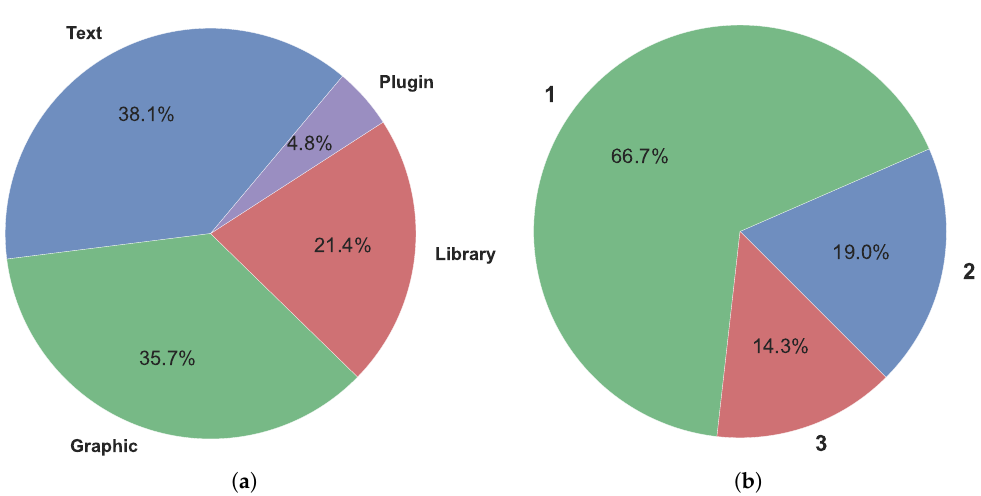
Figure 3. User interfaces implemented in the selected software packages: ( a ) by percentage; and ( b ) by number of interfaces used in a single package. Regarding ( a ), it was defined that, when a package implements n > 1 interfaces, each interface contributes 1/ n to its total usage for all packages.